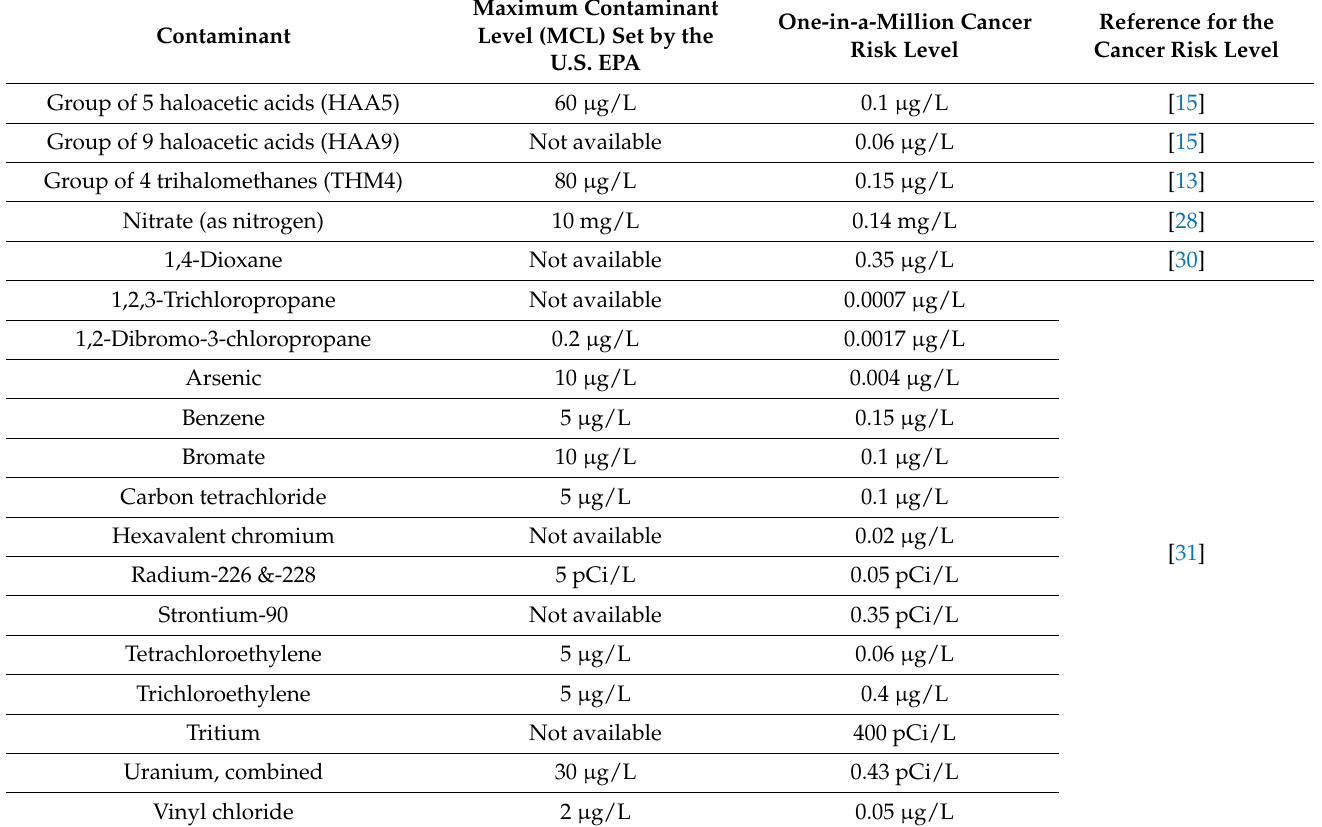
Table A2. Maximum Contaminant Levels set by the U.S. EPA (where available) and one-in-a-million cancer risk benchmarks used for calculations of cumulative cancer risk.